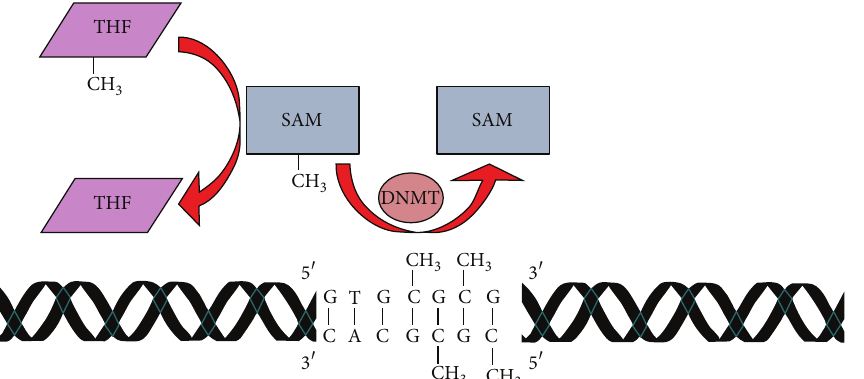
Figure 3: DNA methylation schematic. Addition of a methyl (CH 3 ) group to cytosine residues on CpG islands effectively silences gene expression. Methylation of CpG islands is regulated by S-adenosylmethionine (SAM) and activity of DNA methyltransferase (DNMT). The methyl group derived from methylated tetrahydrofolate (THF) is donated to SAM and SAM then transfers the methyl group to cytosine nitrogenous bases in the DNA sequence. The ApoE (apolipoprotein E) gene (allele 𝜖 3, site A) is an example of where methylation silences (downregulates) ApoE and A 𝛽 accumulates as a result of inhibiting A 𝛽 processing